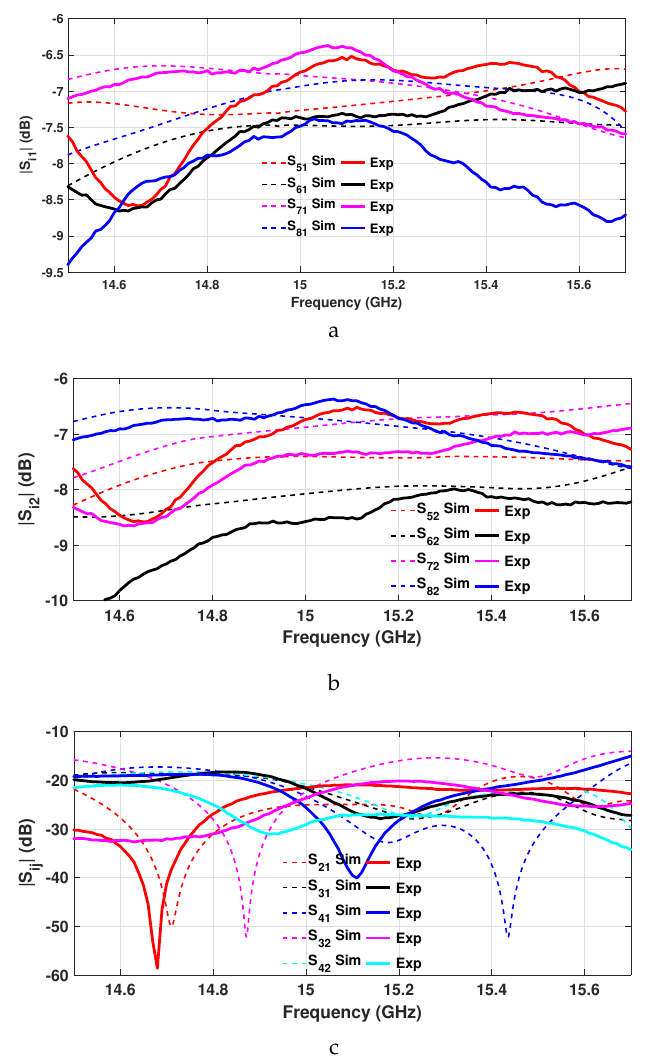
Figure 7. Simulated (Sim) results (taking the conductivity and space between the structure and the lid of the prototype into account) and experimentally (Exp) measured parameters for: ( a ) Coupling Port 1; ( b ) Coupling Port 2. ( c ) Isolation performance for Port 1 and Port